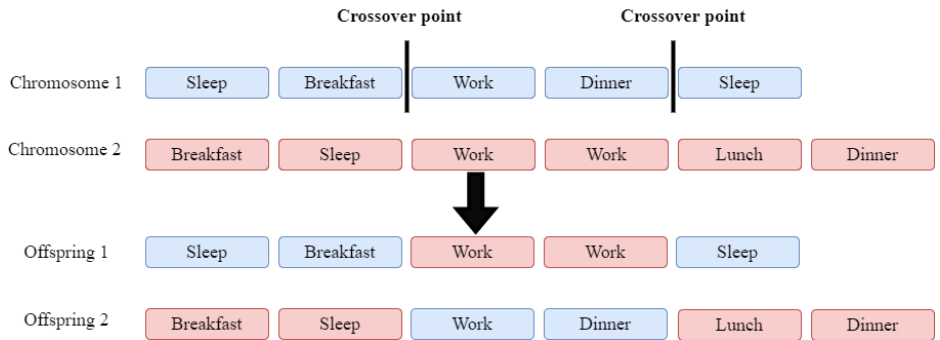
Figure 3. Two-point crossover on two individuals representing daily activities sequence of a person.